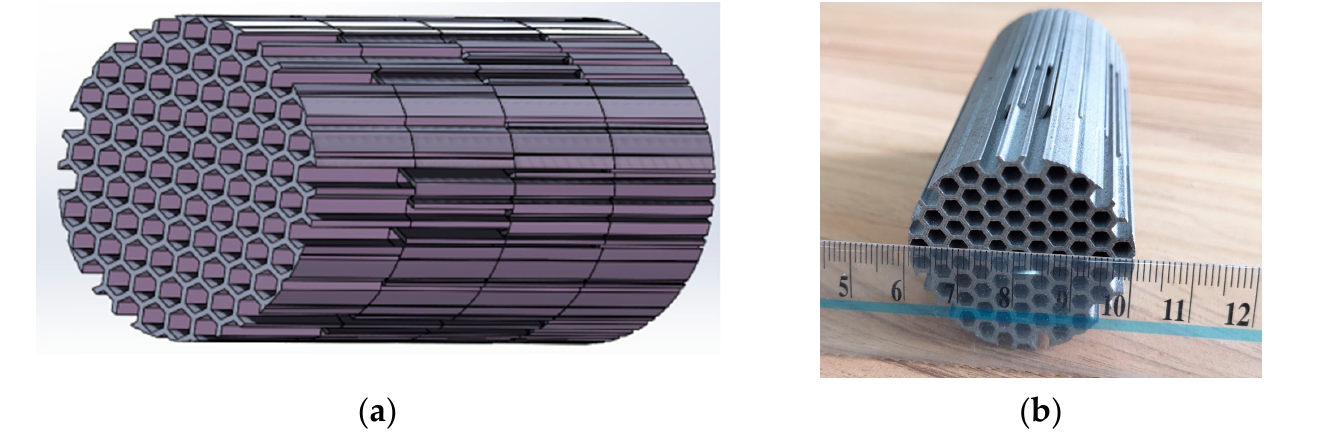
Figure 1. Physical model of HTGR ( a ) model ( b ) 3D–printed regenerator.